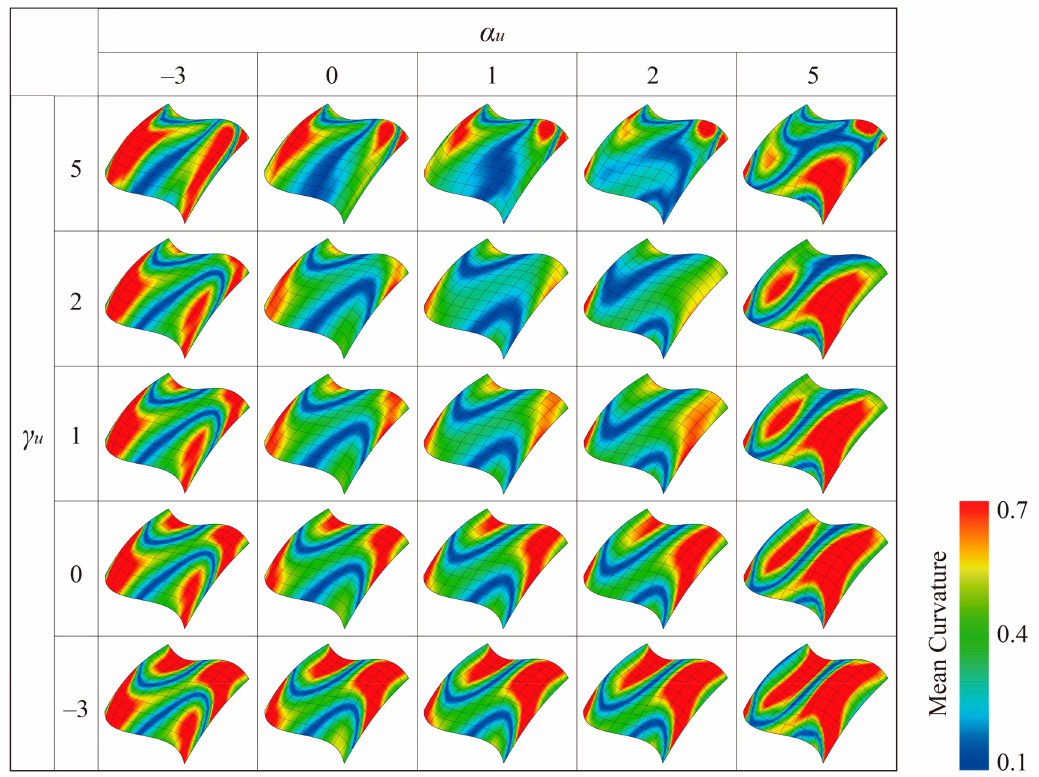
Figure 4. E ff ect on mean curvature of various shape parameters α u and γ u ∈ [ − 3, 5] on a SQ-Coons surface